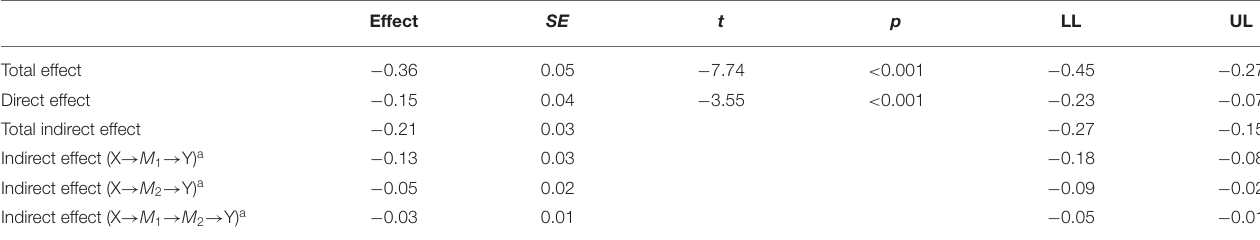
TABLE 3 | Total, direct, and indirect effects of disagreeableness (X) on love (Y) through depression stigma (M1) and empathic concern (M2) in Study 1. Effect SE t p LL UL Total effect − 0.36 0.05 − 7.74 < 0.001 − 0.45 − 0.27 − 0.15 0.04 − 3.55 −